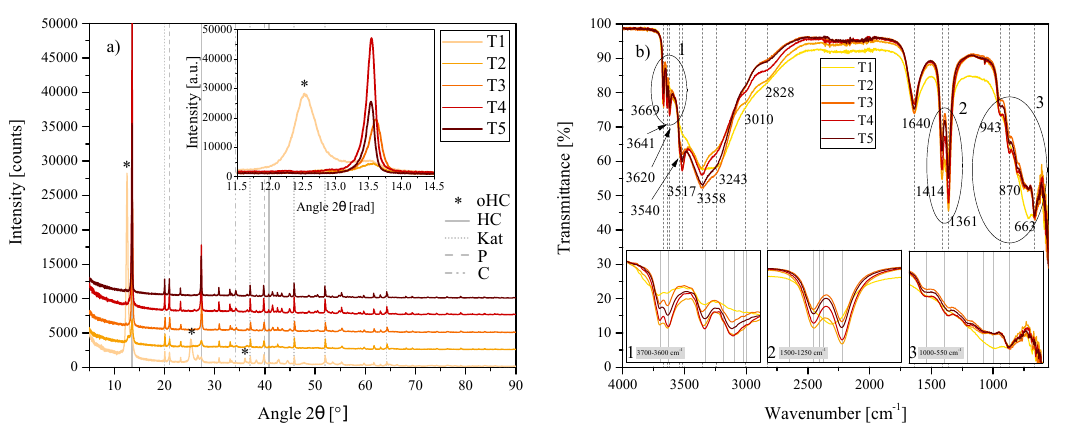
Figure 5. ( a ) XRD results of the temperature series T1, T2, T3, T4 and T5 between 5 ◦ 2 θ and 90 ◦ 2 θ . Each scan is y-shifted by 2500 counts. The inset depicts the primary LDH peaks and change in position. HC = hydrocalumite, oHC = secondary HC-like phase, Kat = katoite, P = portlandite and C = calcite. ( b ) FTIR-ATR scans of the temperature series T1, T2, T3, T4 and T5 between 4000cm − 1 and 550cm − 1 . The three insets show the regions: ( 1 ) 3700cm − 1 – 3600cm − 1 , ( 2 ) 1500cm − 1 – 1250cm − 1 , ( 3 ) 1000cm − 1 – 550cm − 1 in detail. Dashed and solid grey lines indicate the maxima of vibrations. T1 = 20 ◦ C, T2 = 40 ◦ C, T3 = 60 ◦ C, T4 = 80 ◦ C and T5 = 90 ◦